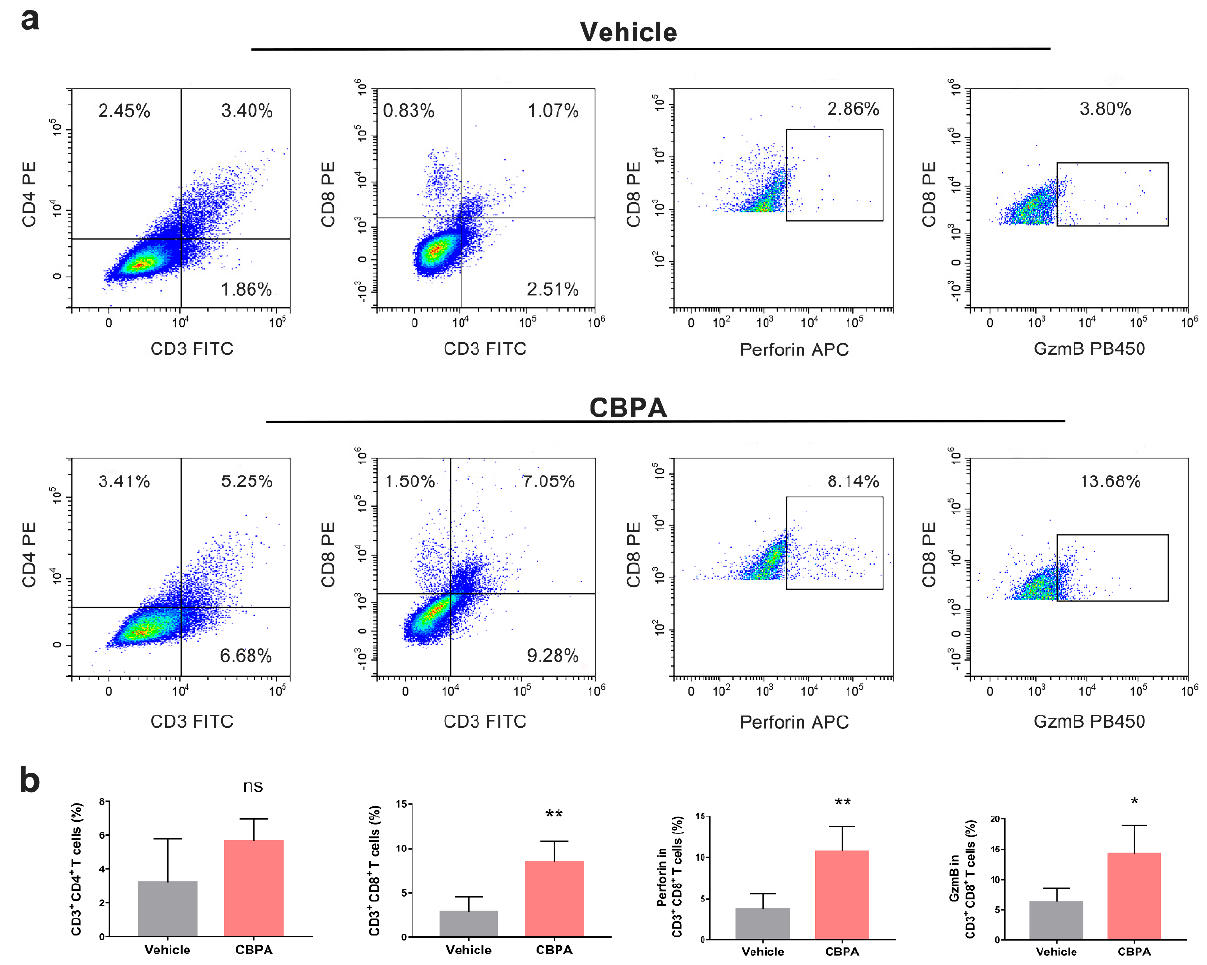
Figure 8. The in vivo antitumor mechanism of CBPA. ( a ) Flow cytometry analysis of TILs and intracellular perforin and GzmB secretion in tumor tissues collected from MC38-bearing mice administered CBPA (10 mg/kg) or the vehicle. ( b ) All quantitative data from the flow cytometry analysis (n = 4) are shown as means ± SEM, * p < 0.05; ** p < 0.01, unpaired t -test; ns, not significant.